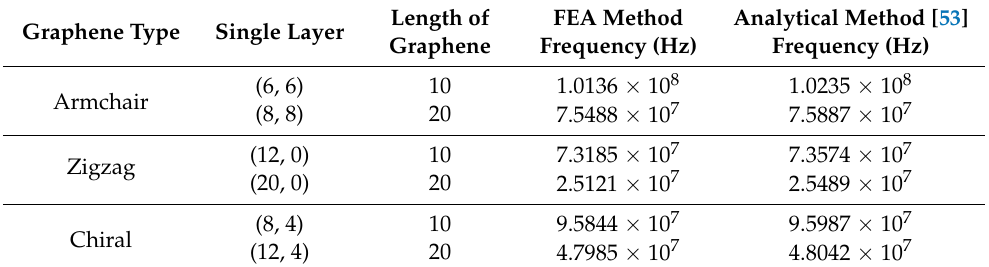
Table 1. Results comparison of FEA method and analytical method.